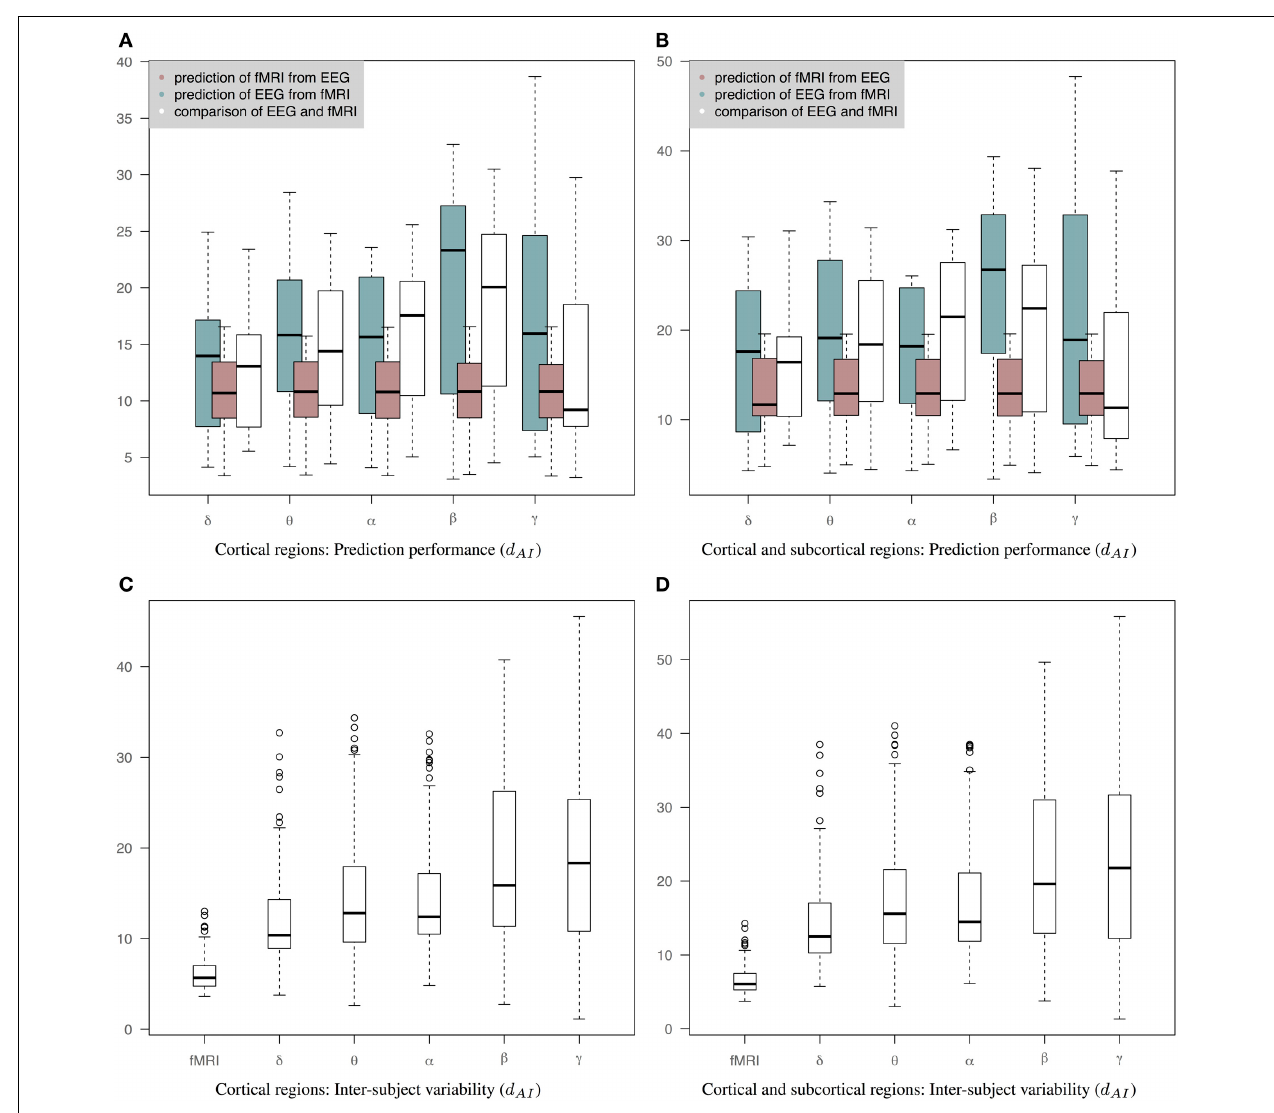
FIGURE 6 | Results of prediction performance (AWE). This figure presents the same results as Figure 5 but EEG time series have been averaged within each epoch, which is equal to the fMRI-TR. The distance between the rs-fMRI precision matrices and each of the EEG frequency banded precision matrices estimated with d AI . The smaller the distance the more similar the connectivity matrices should be. (A) It shows results based only on cortical regions that summarize the prediction performance of fMRI from EEG (brown box-plots) and vice-versa (green box-plots) across bands, as well as the distance between the fMRI precision matrices and